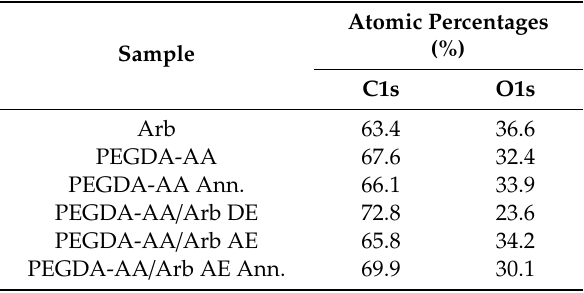
Table 1. Atomic composition of the samples by means of XPS